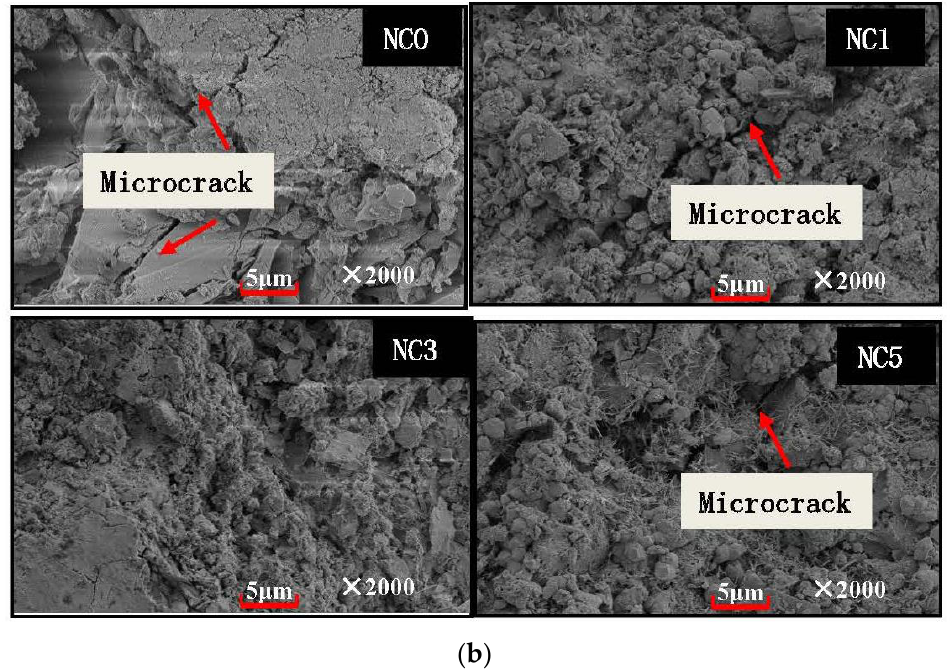
Figure 7. SEM results of concrete before and after freeze-thaw cycles. ( a ) Microstructures of concrete with NCM before freeze–thaw cycles; ( b ) Microstructures of concrete with NCM after 30 freeze– thaw cycles.